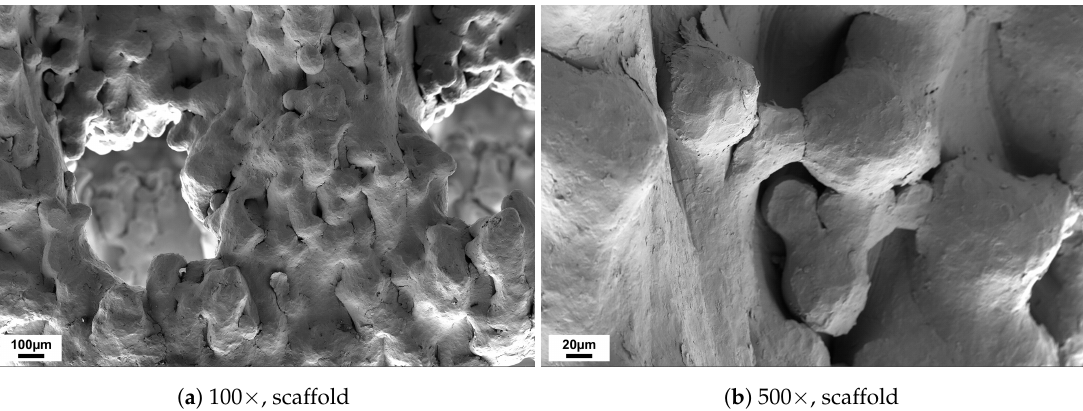
Figure 3. Scanning electron microscope images showing the morphologies of electron beam melted Ti-6Al-4V three-dimensional porous scaffold structure with 800 µ m pore and lattice size